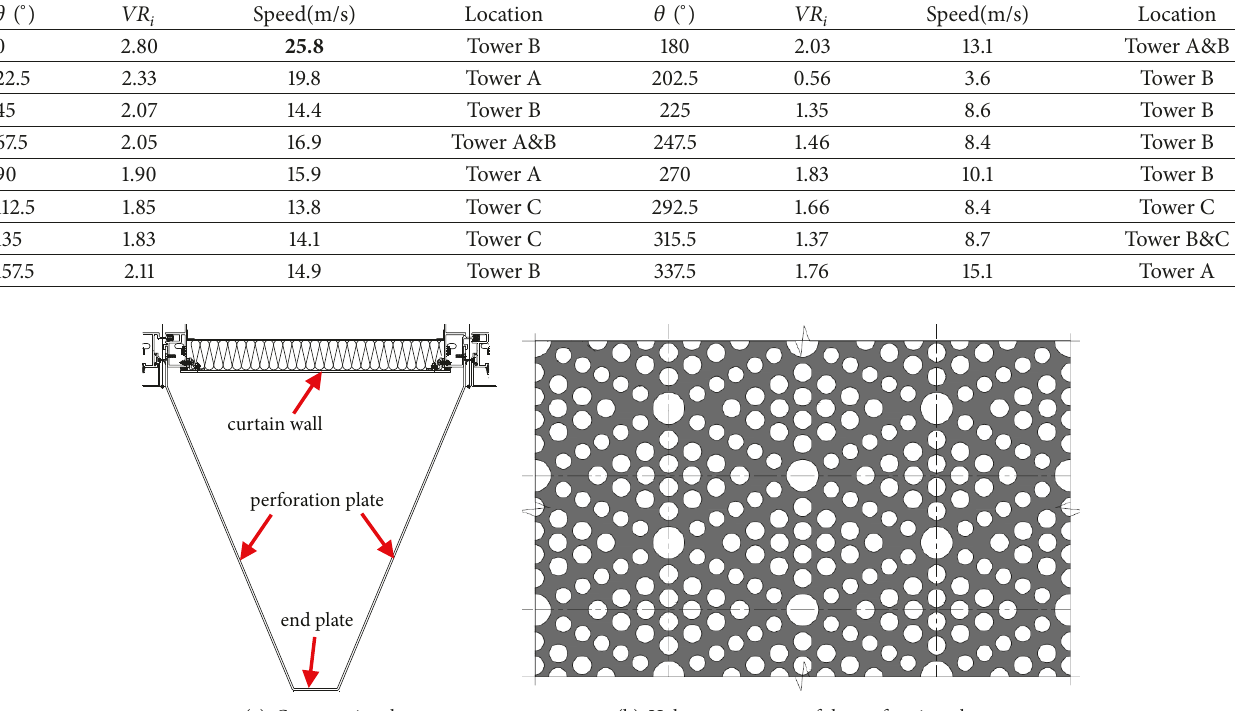
Figure 7: External sunshade perforation structure diagrammatic